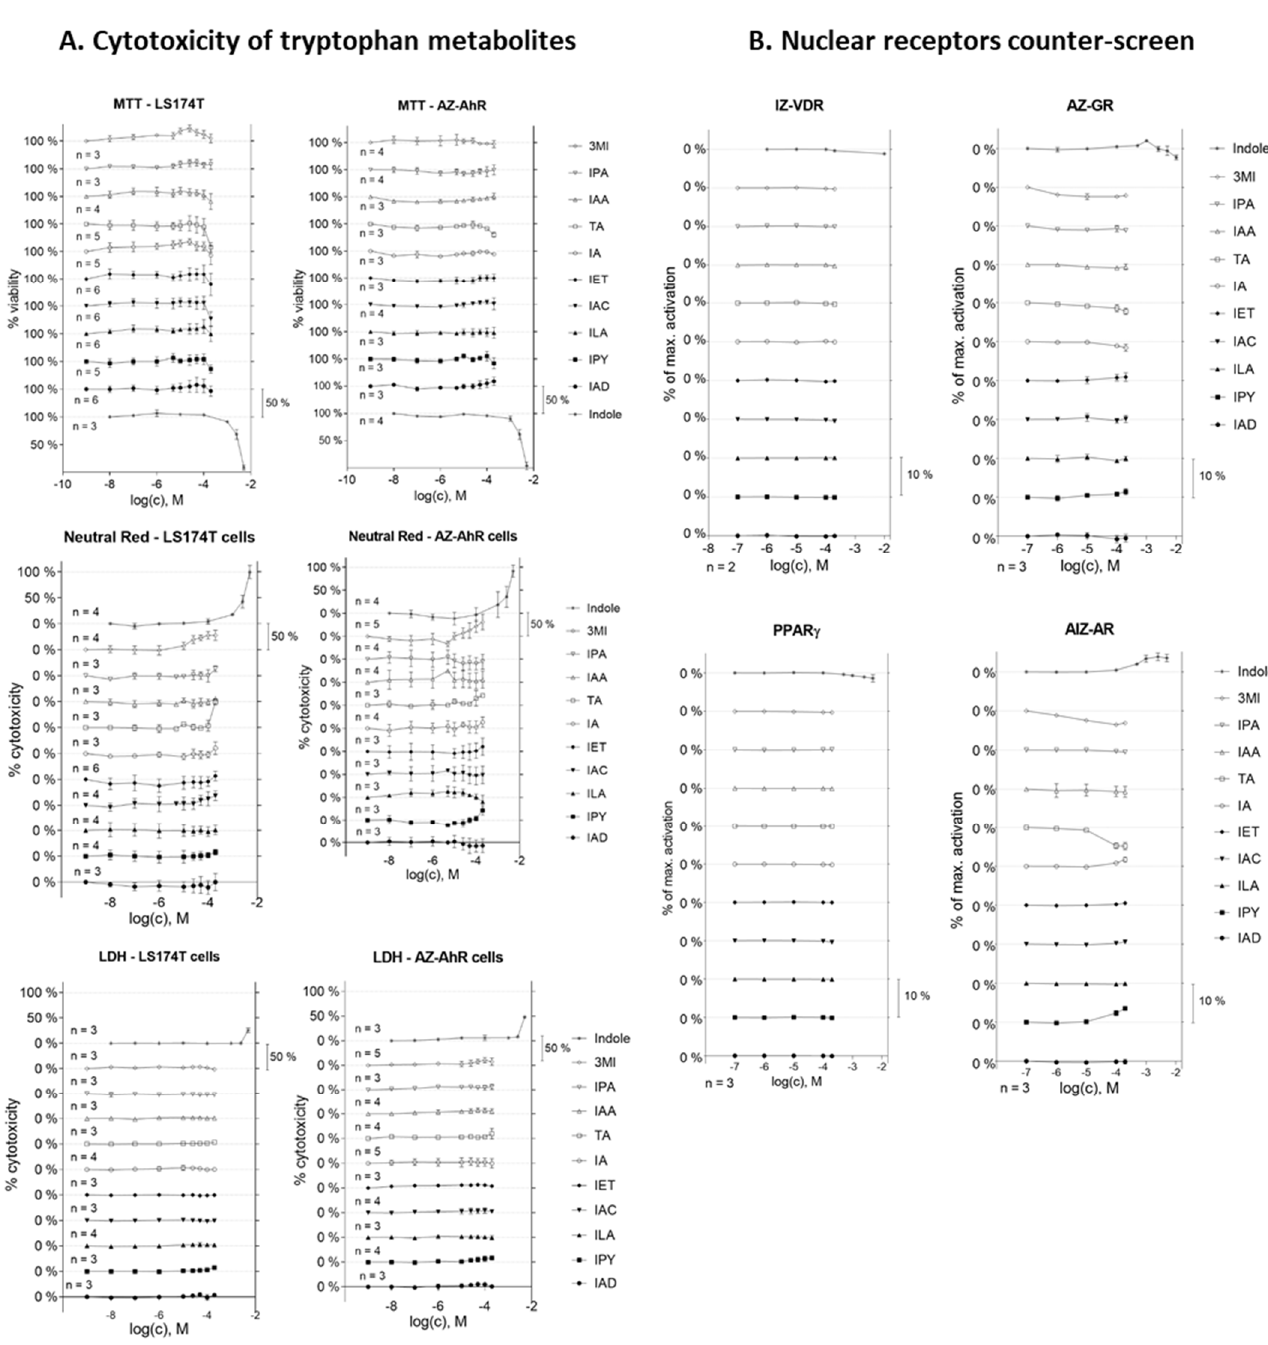
Figure 1. The effect of tryptophan metabolites on the cell viability and the activity of nuclear receptors. Cells were treated for 24 h with the tested compounds at concentrations ranging from 1 nM to 200 µ M (indole from 10 µ M to 10 mM). ( A ) Cell viability in LS174T and AZ-AHR cells. The MTT, NR, and LDH assays were performed as described in the experimental section. Data are the means from at least three consecutive cell passages and are expressed as a percentage of the viability (MTT) or cytotoxicity (NR, LDH) of the control cells. ( B ) The activity of VDR, GR, PPAR γ , and AR receptors in stably transfected reporter cell lines. A luciferase assay was performed as described in the experimental section. Vehicle DMSO (0.1% v/v) was used as a negative control, and VD3 (75 nM), DEX (100 nM), 15d-PGDJ (40 µM), or DHT (100 nM) as positive controls, respectively. Data are the means from at least three consecutive cell passages and the effects of tested compounds are expressed as a % of induction by the positive control.